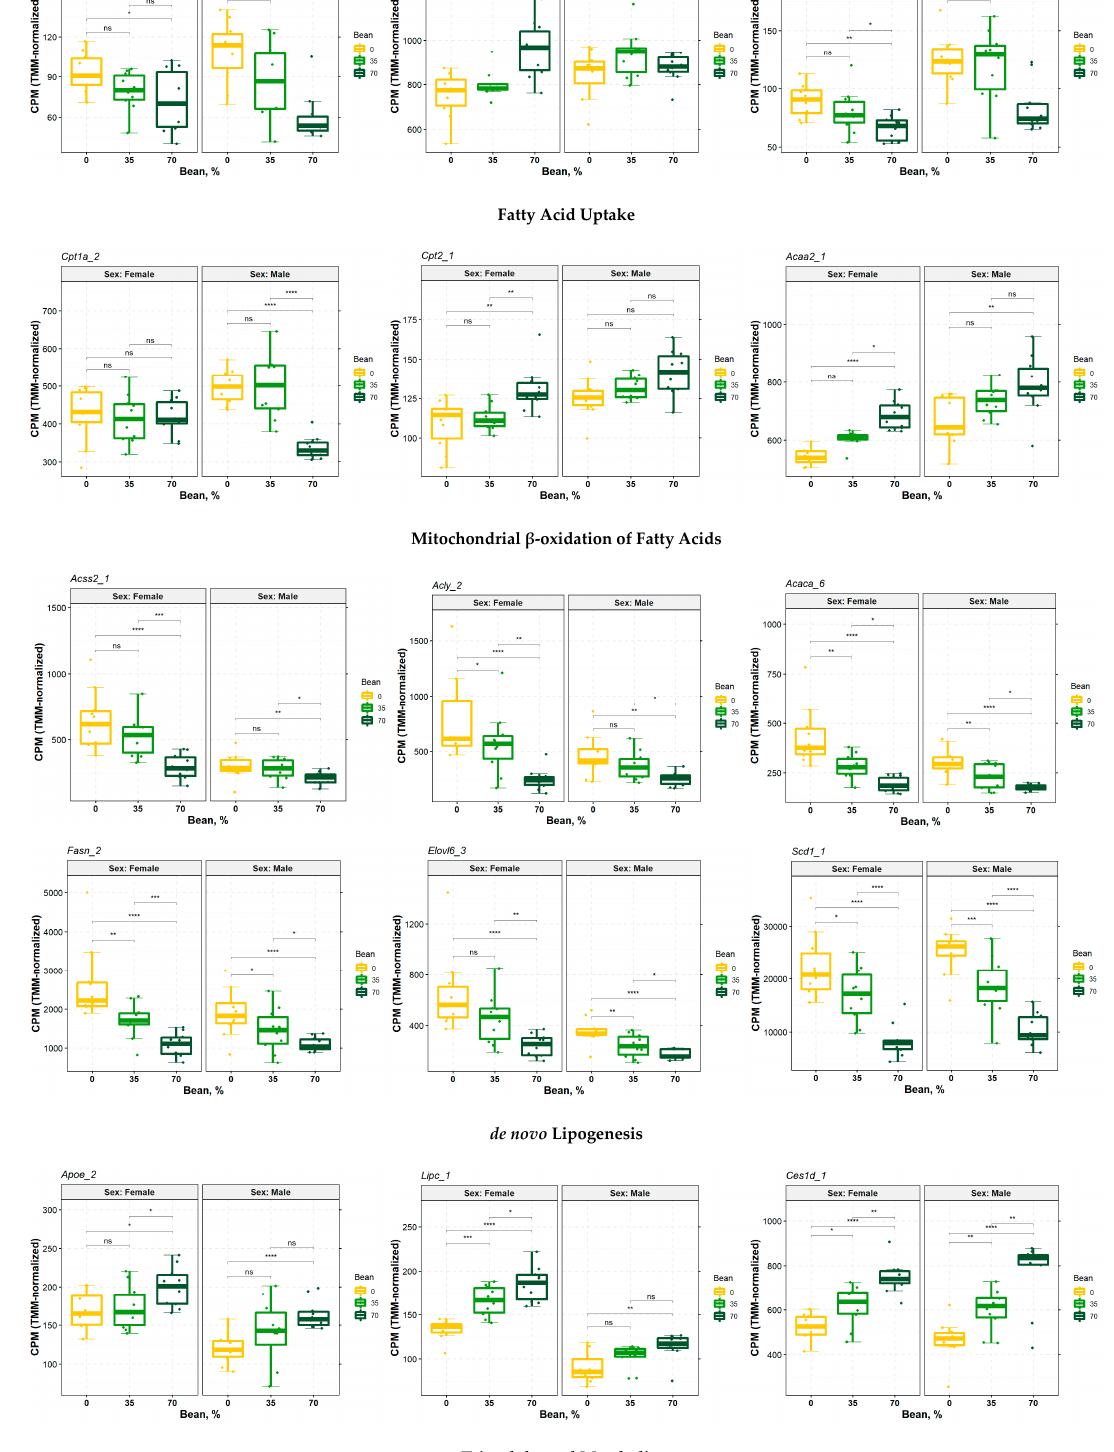
Figure 6. Expression of genes involved in lipid metabolism in the livers of female and male mice upon consumption of beans. Differential expression analysis performed in CLC Genomic Workbench. * p -value < 0.05; ** p -value < 0.01; *** p -value < 0.001; **** p -value <